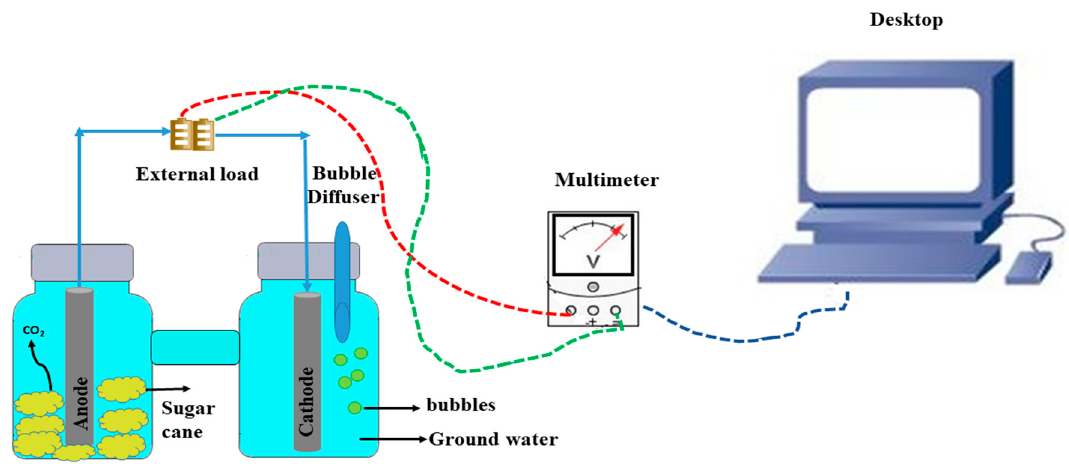
Figure 2. The schematic design and working pathway of a benthic microbial fuel cell with two chambers. 127